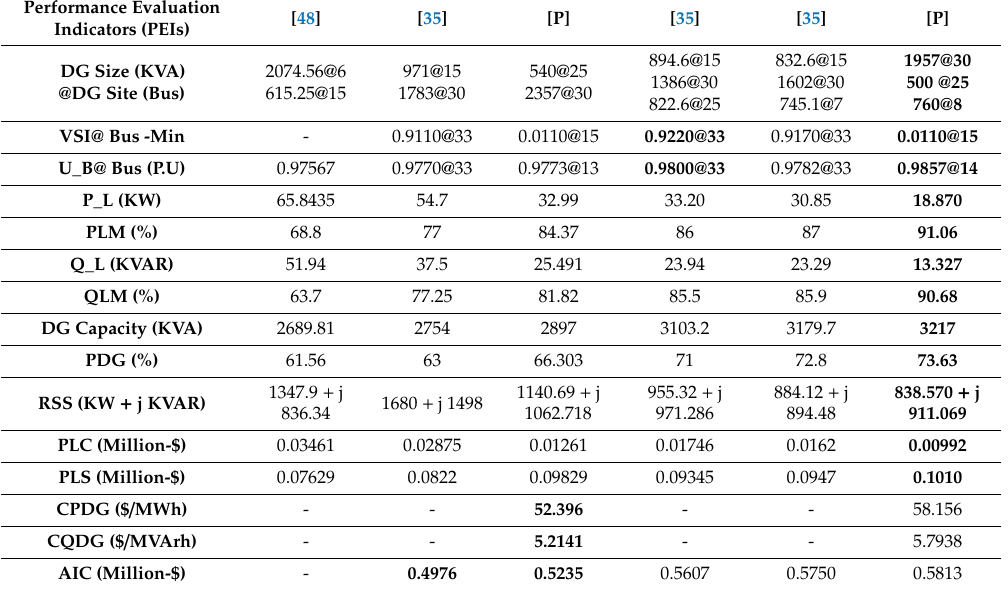
Table 12. Comparisons of results with various scenarios of case 2 for 33-bus test system (DG@PF = 0.90 ± 3%).